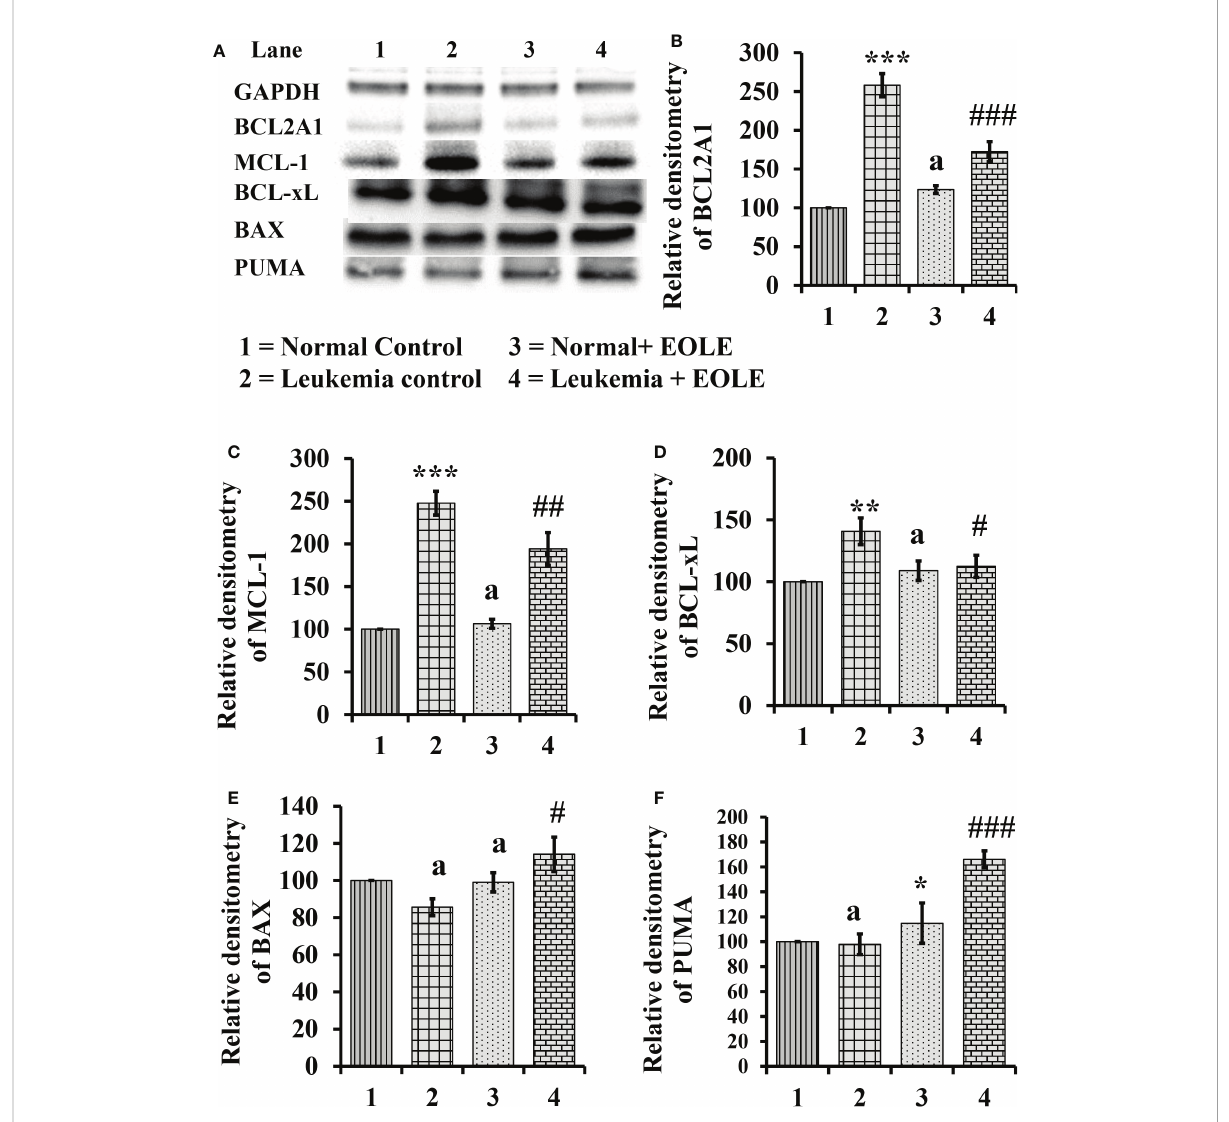
FIGURE 7 Figure showing the result of western blot analysis for many apoptotic pathway proteins in the bone marrow of mice, where (A) Image of protein bands, (B) Densitometry plot for BCL2A1, (C) Densitometry plot for MCL-1, (D) Densitometry plot for BCL-xL, (E) Densitometry plot for BAX, (F) Densitometry plot for PUMA. Values are expressed as mean ± SD of 3 observations. The statistical signi fi cance was tested using one-way ANOVA following Tukey ’ s multiple comparison tests by comparing the values as, Group-1 vs . Group-2, 3; Group-2 vs . Group- 4. P-value, p < 0.05 was considered as statistically signi fi cant. When compared with Group-1 the level of signi fi cance was denoted as, a = not signi fi cant when p > 0.05; * when p < 0.05; ** when p < 0.01; and *** when p < 0.001. When compared with Group-2, b = not signi fi cant when p > 0.05; # when p < 0.05; ##when p < 0.01; and ###when p <